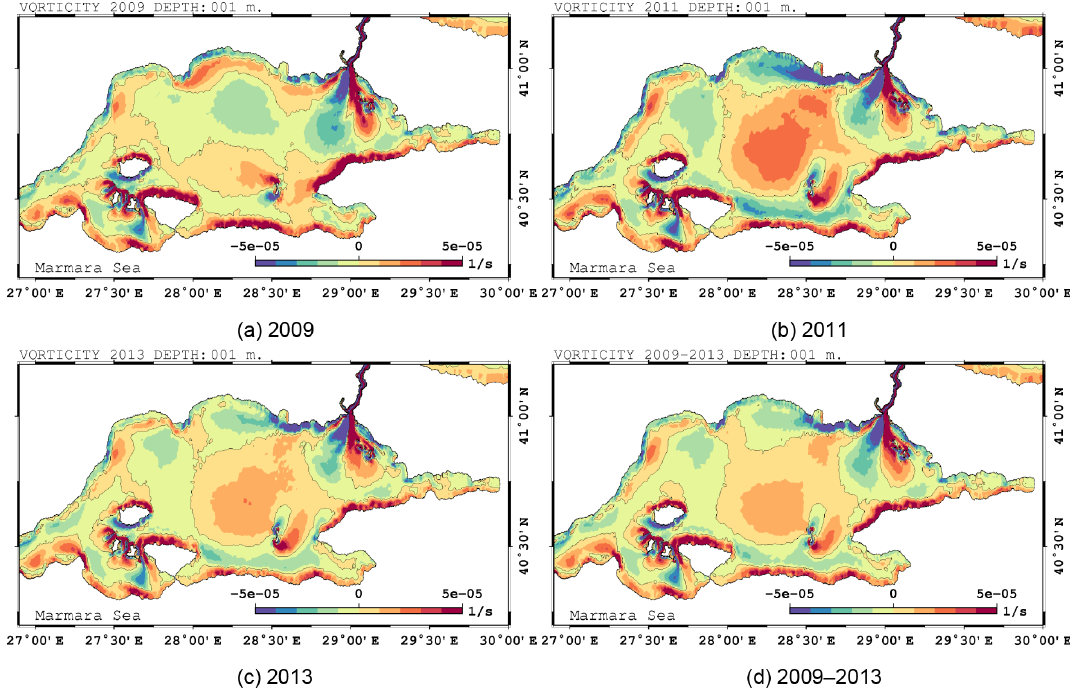
Figure 17. Annual mean of surface vorticity in the Sea of Marmara at the surface for (a) 2009, (b) 2011 and (c) 2013, and (d) the surface vorticity mean for the 2009–2013